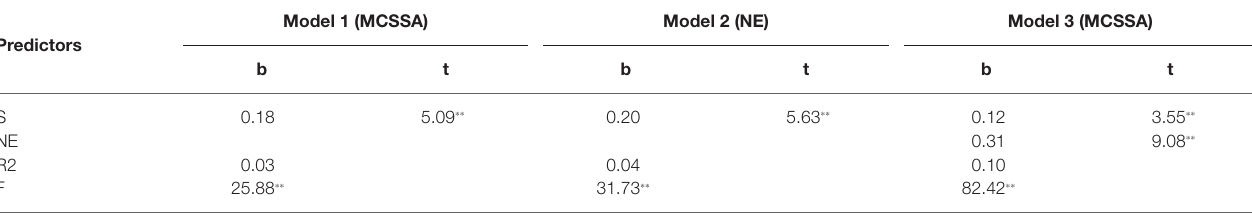
TABLE 2 | Testing the mediation effect of perceived stress on smartphone addiction.